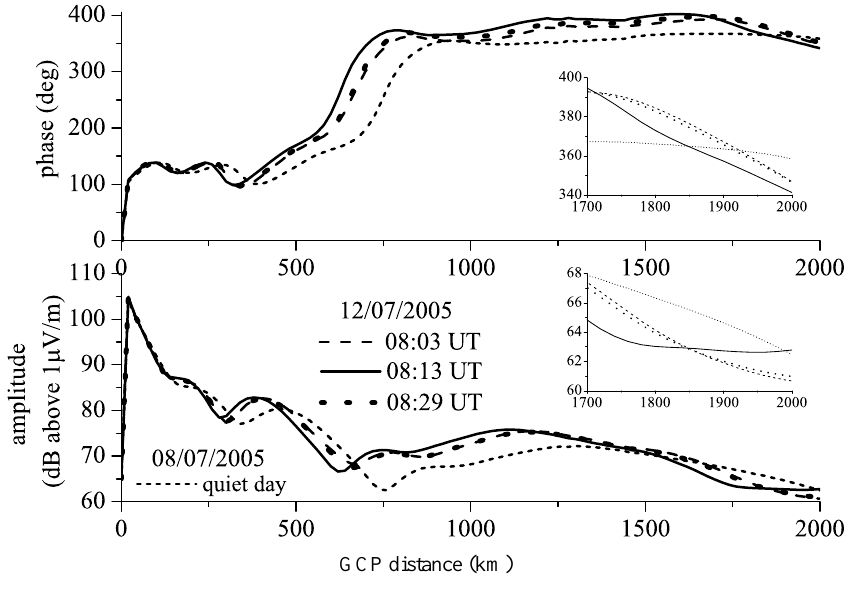
Fig. 11. Variation of phase and amplitude of the GQD signal along the GCP distance from Skelton to Belgrade, calculated for three characteristic times during the C7.5 event on 12 July 2005 (see Fig. 3). The close up of the last 300km on GCP is added to the phase and amplitude